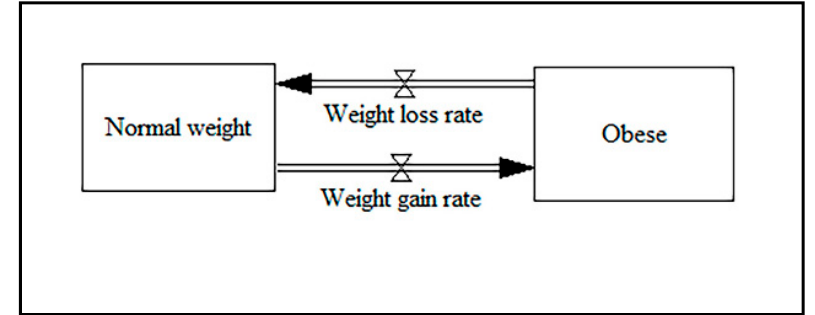
Figure 6. The core part of the stock-flow diagram for obesity.